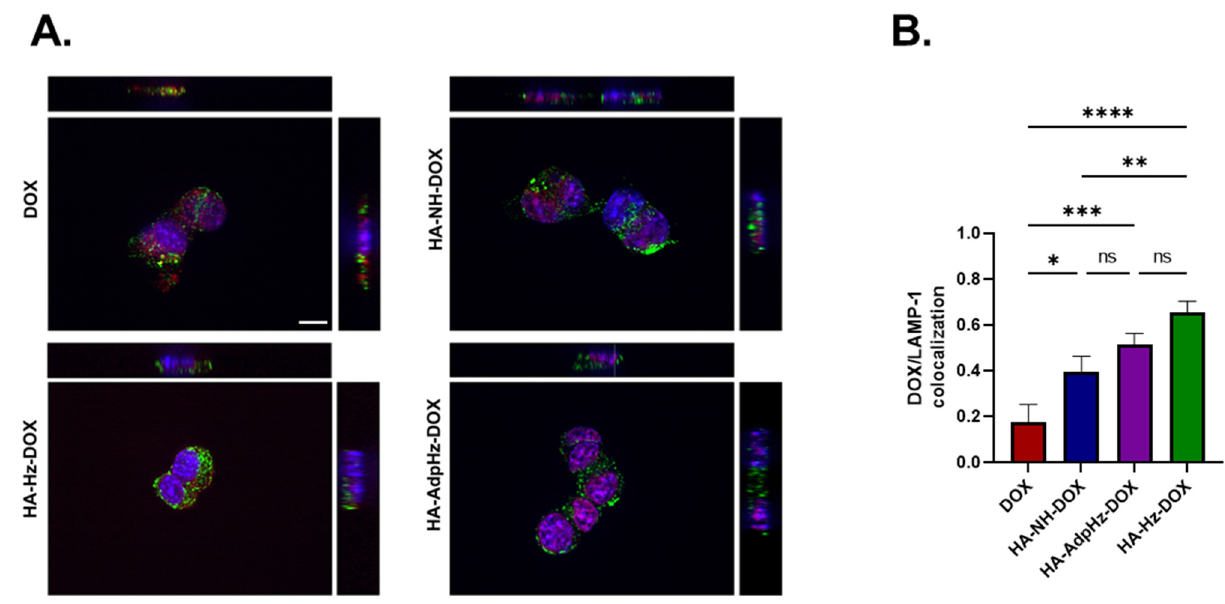
Figure 4. Confocal microscopy images of GL261 cells for lysosome accumulation assay. ( A ) GL261 cells were incubated with free DOX, HA-NH-DOX, HA-AdpHz-DOX, and HA-Hz-DOX conjugates for 6 h, nuclei were stained with DAPI, and lysosomes were stained with the LAMP-1 antibody. Pictures were obtained by Z-stack imaging (DAPI: blue; DOX: red; LAMP-1 antibody: green; LAMP- 1+DOX: yellow). ( B ) Quantification of colocalization analysis for DOX or HA-DOX conjugates with LAMP-1 (Pearson’s coefficient) (Mean, error bar = SD, N = 3, statistical analysis obtained by one-way ANOVA multiple comparison: ns = not significant, * p < 0.05, ** p < 0.01, *** p < 0.001, **** p < 0.0001).